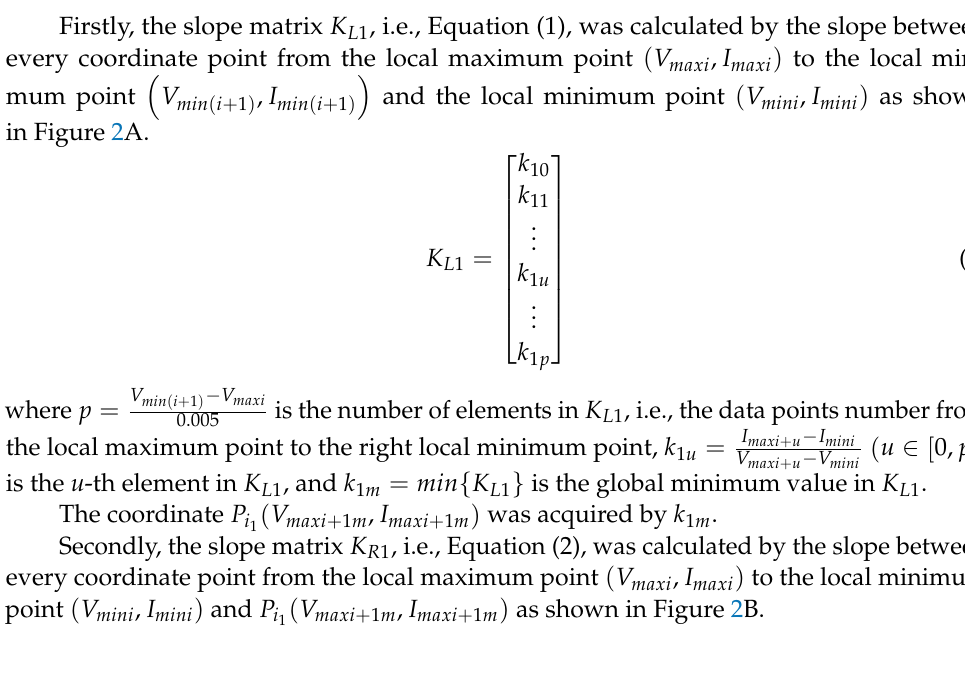
Figure 1. Schematic representation of the SWASV curve smoothed by S-G algorithm ( A ), the extreme points identified by the peakdet function ( B ), the end of the SWASV curve set as the minimum point ( C ), and the segmentation of SWASV curve ( D ). (SWASV response curve of 150 µ g/L Zn 2+ , 35 µ g/L Cd 2+ , 175 μg/L Pb 2+ , 300 μg/L Bi 3+ , and 100 μg/L Cu 2+ ).